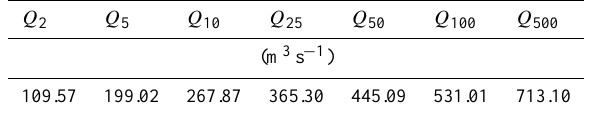
Table 1. The flood hydrograph of Akçay Creek.